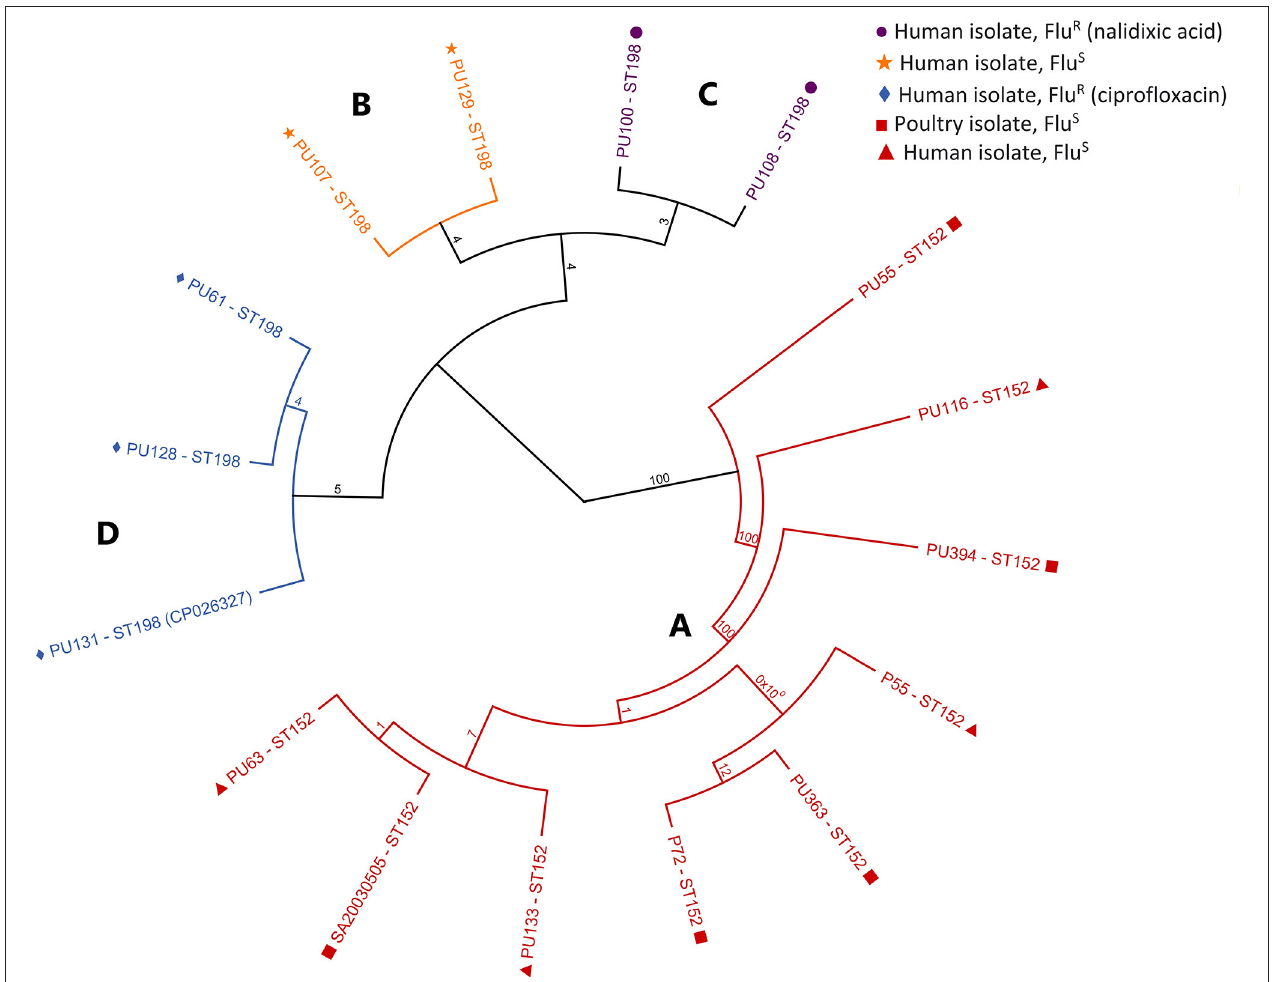
FIGURE 1 | (A-D) Phylogenetic tree of Salmonella Kentucky ST198 and ST152 strains sequenced in this study. Maximum-likelihood phylogenetic tree based on core-genomic SNPs in S. Kentucky ST198 and ST152 strains mapped to the genome of ST198 reference strain PU131 was generated using PhyML. The tree is rooted in the ST152 cluster. Branch names are labeled by strain number and ST type. Bootstrap values represent the percentage of concurring bootstraps from 100